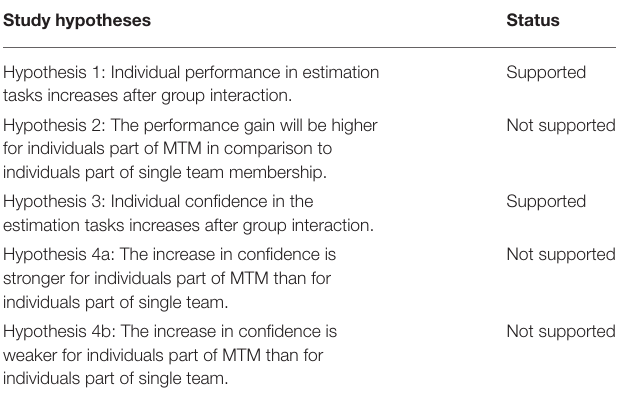
TABLE 4 | Overview of the hypotheses tested in the